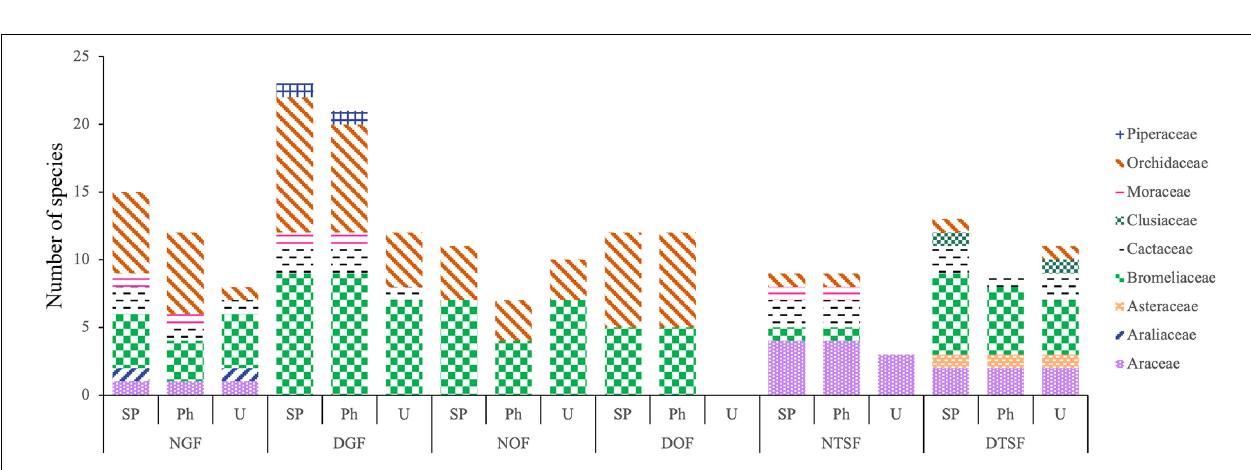
FIGURE 4 | Number of species per family in the entire sampled plot (SP), the phorophytes (Ph) and the understory (U) in each sampling site (NGF = natural gallery forest, DGF = disturbed gallery forest, NOF = natural oak forest, DOF = disturbed oak forest, NTSF = natural tropical sub-deciduous forest, DTSF = disturbed tropical sub-deciduous